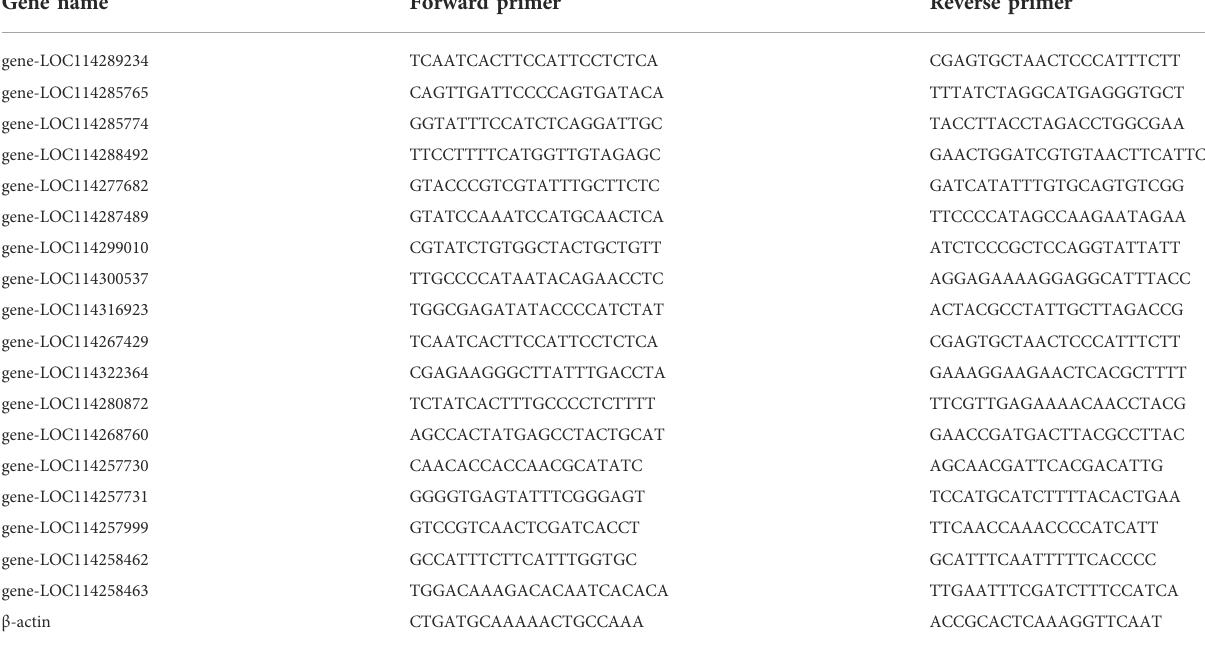
TABLE 1 Primer sequences used for the qRT-PCR